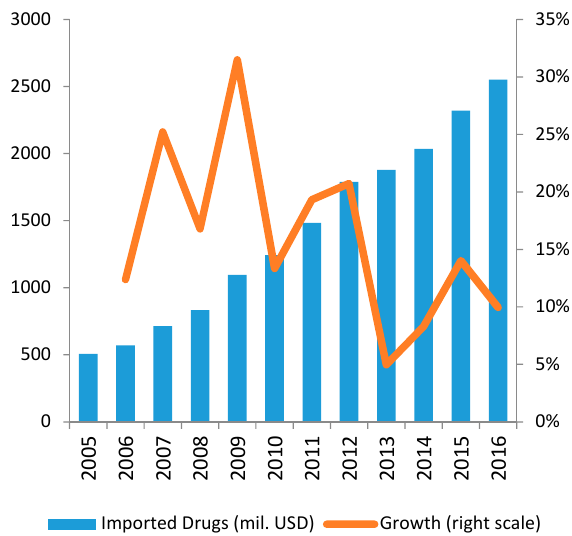
Figure 5. Import Volume of Drugs in 2005–2016.